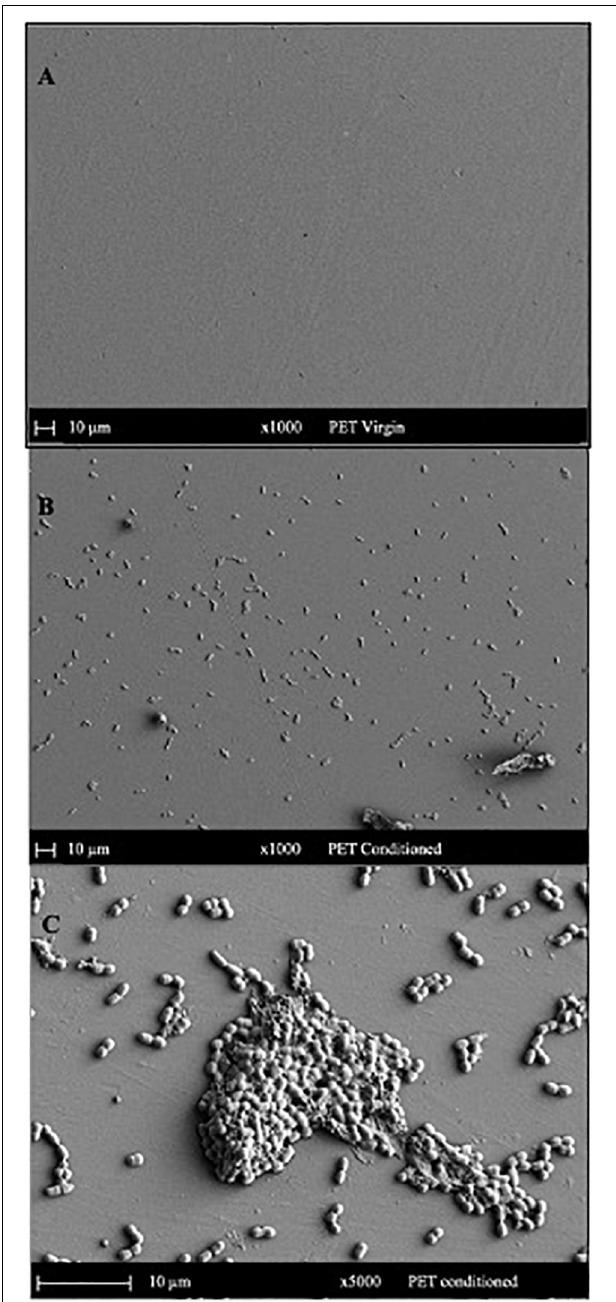
FIGURE 5 | SEM images indicating the surface morphology of the (A) virgin PET and (B,C) conditioned PET cards in natural seawater. The surface of conditioned plastic shows the attachment of coccoid-shaped bacterial cells after 24 h of immersion in natural seawater at 22 ◦ C.